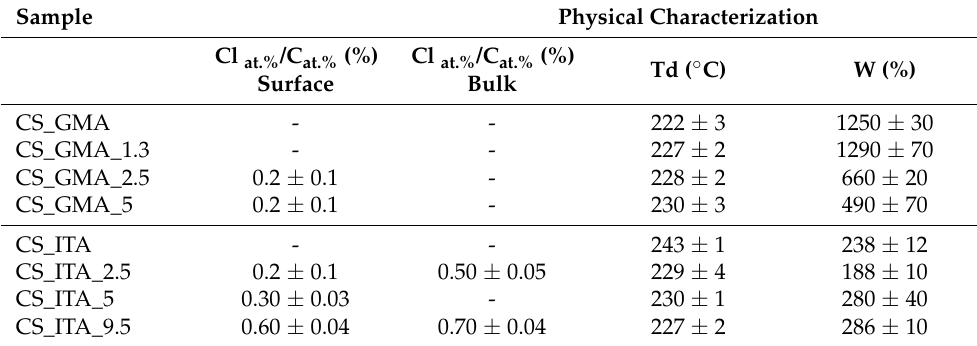
Figure 5. EDX spectra of ( A ) CS_GMA, ( B ) CS_ITA, ( C ) CS_ITA_9.5 and ( D ) CS_GMA_2.5. Table 2. Summary of CS_GMA and CS_ITA properties. Cl at.% /C at.% (%) ratio as revealed by EDX analysis, T d is the temperature at which the maximum weight loss rate occurred. W (%) indicates the maximum